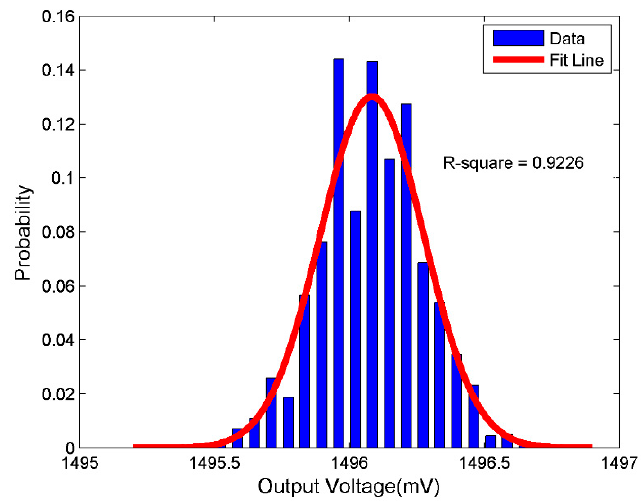
Figure 5. Probability density distribution of the output voltage when XOUT = − 1 g.